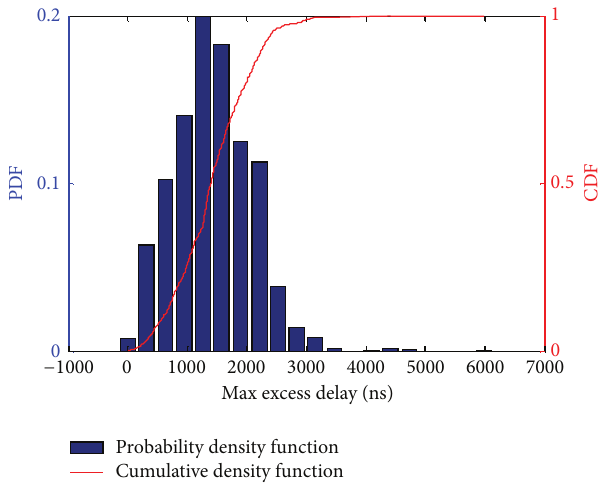
Figure 6: PDF and CDF of maximum excess delay values in HSR hilly